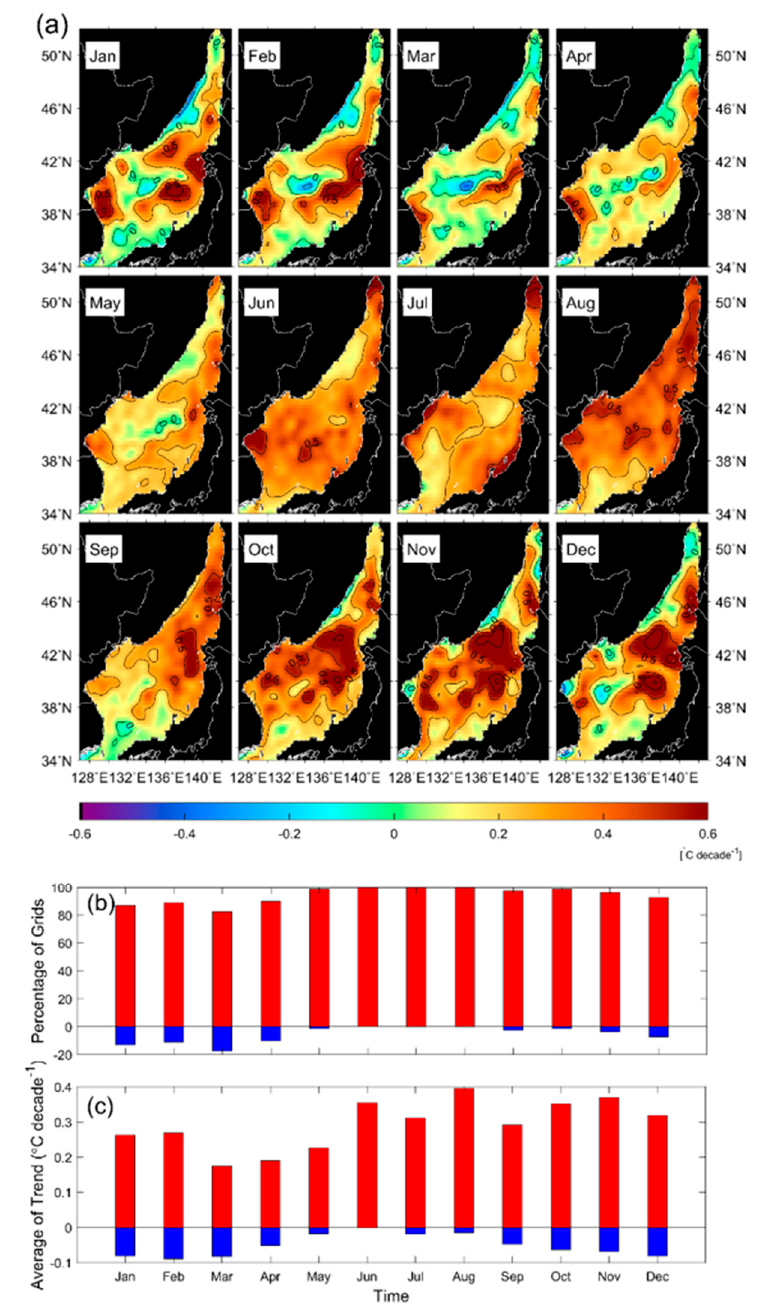
Figure 7. ( a ) Monthly variations of the SSTA trends from the OISST database for the observation period from 1982 to 2018; ( b ) monthly percentage of the number of grids; and ( c ) monthly regional averaged trend of ( a ) only for positive (red) and negative (blue) values.